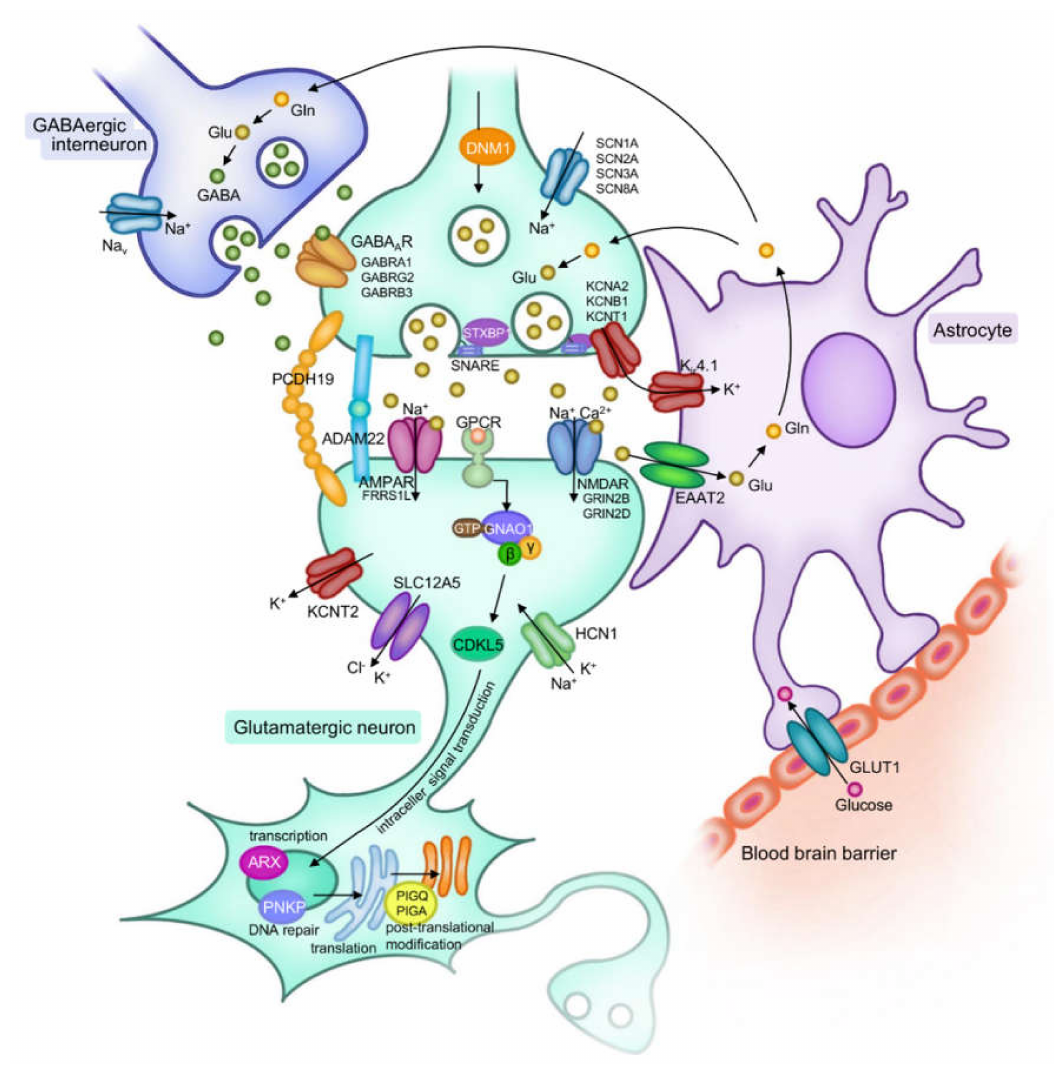
Figure 1. Schematic model depicting main functions associated with monogenic developmental and epileptic encephalopathies